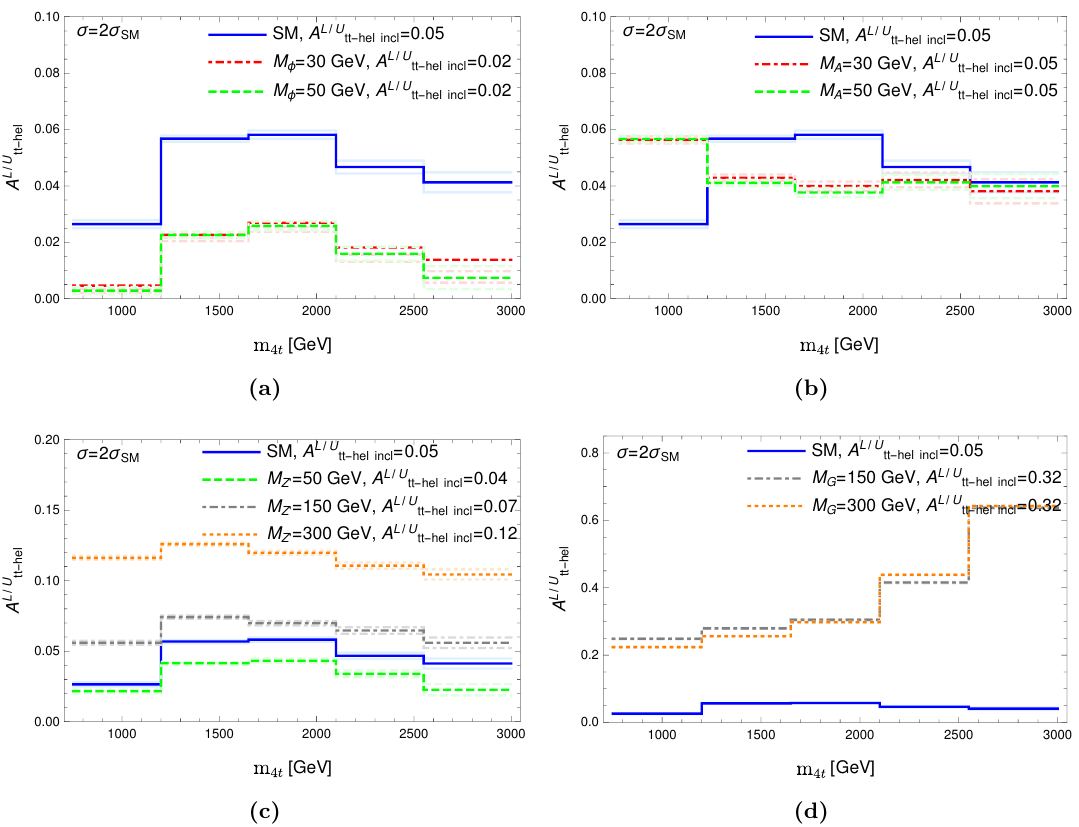
Figure 9. A L=U asymmetry (see eq. 3.1) as a function of the invariant mass of the four-top system. tt-hel Shown are the predictions for the SM (blue) and the loose benchmark points (i.e. giving (cid:27) = 2 (cid:27) SM ) of the NP models considered: (a) Scalar, (b) Pseudo-scalar, (c) Z 0 , and (d) Graviton. Also quoted are the inclusive asymmetries, i.e. averaged over the four-top invariant mass spectrum. Analogous results for the tight benchmark points (i.e. giving (cid:27) = 1 : 5 (cid:27) SM ) are shown in (cid:12)gure